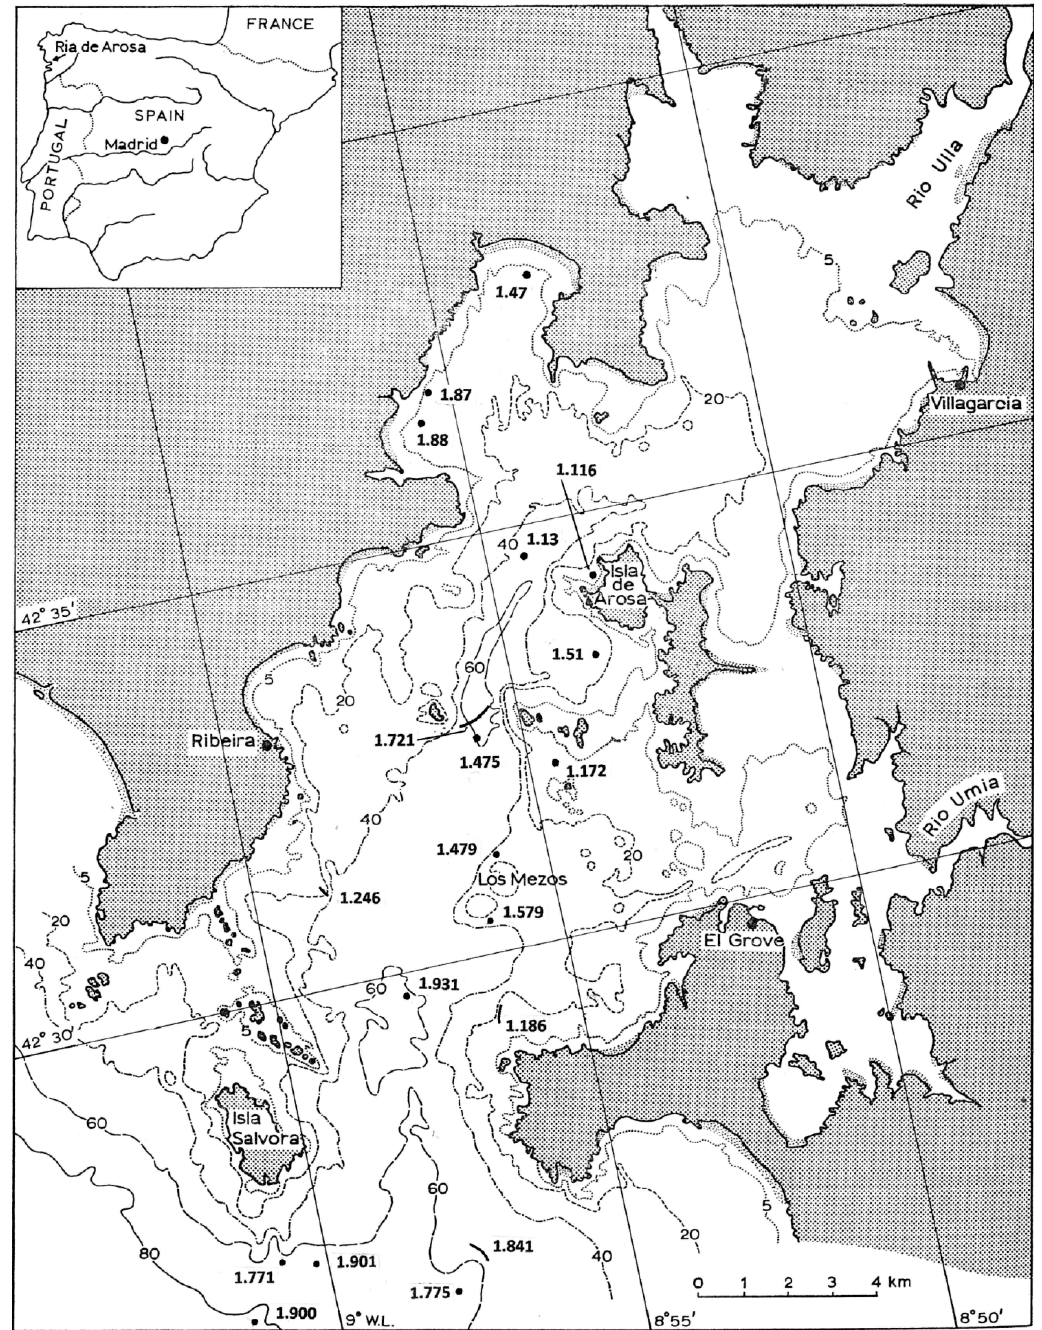
Figure 7. Map of the Ría de Arosa, Galicia, Northwest Spain with the stations at which otoliths were found in sediment samples. The stations are indicated by dots or lines. Modified after Cadeé [71].